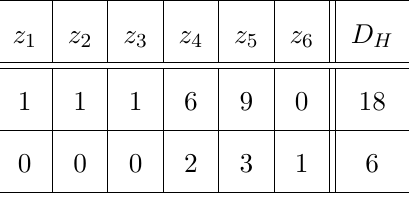
Table 9 . Weights for P [1 , 1 , 1 , 6 , 9]